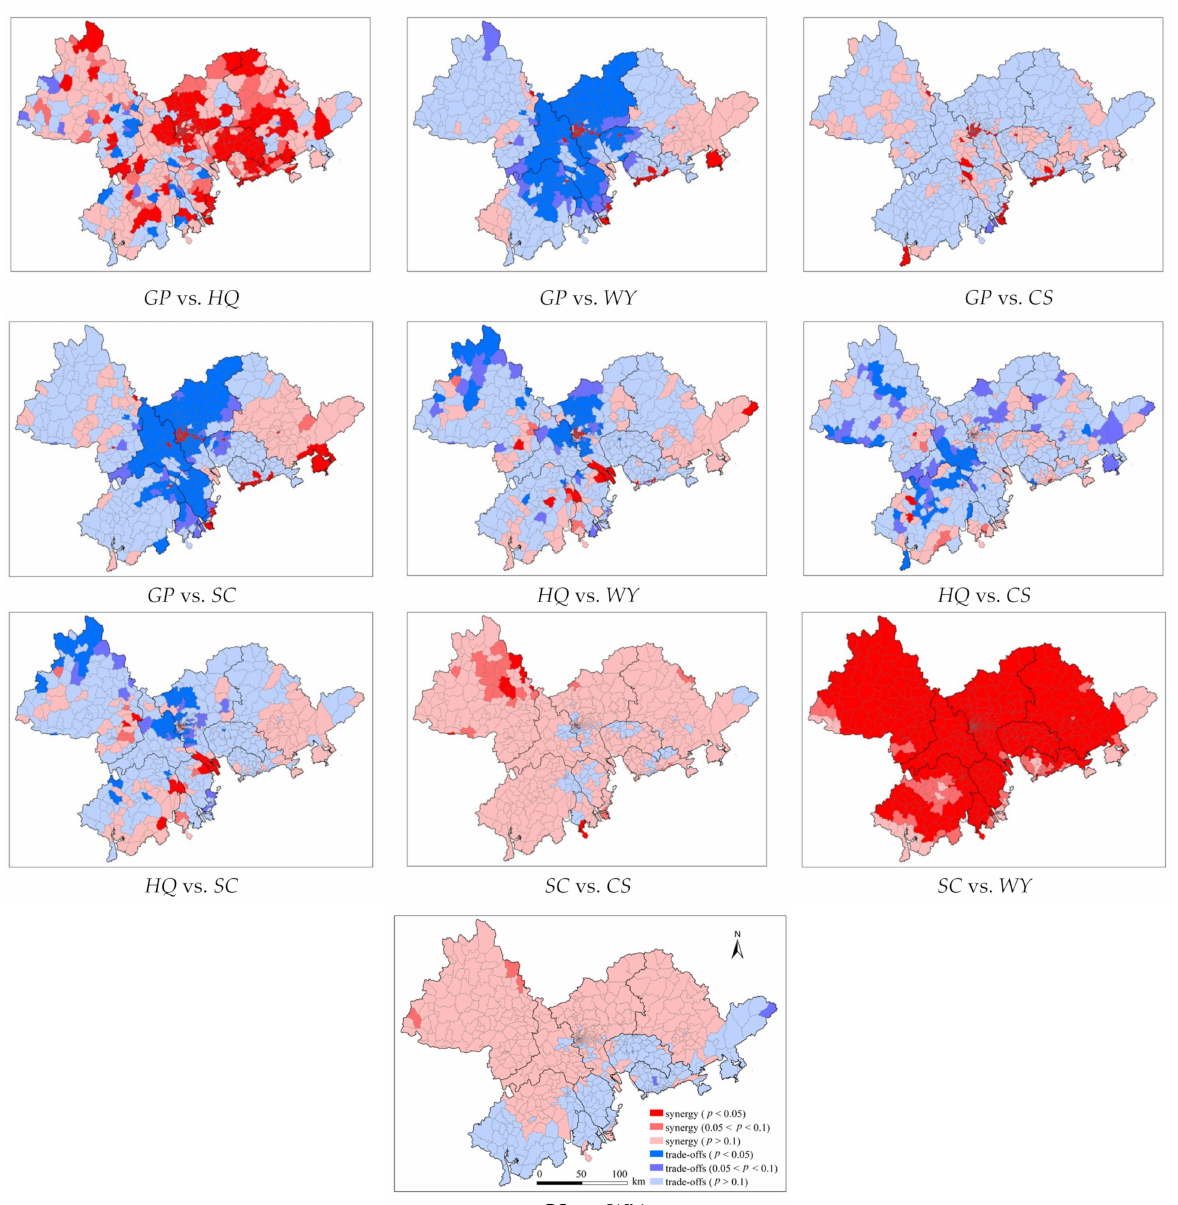
Figure 6. Spatial distribution of the ecosystem services trade-offs/synergies at township level in the Pearl River